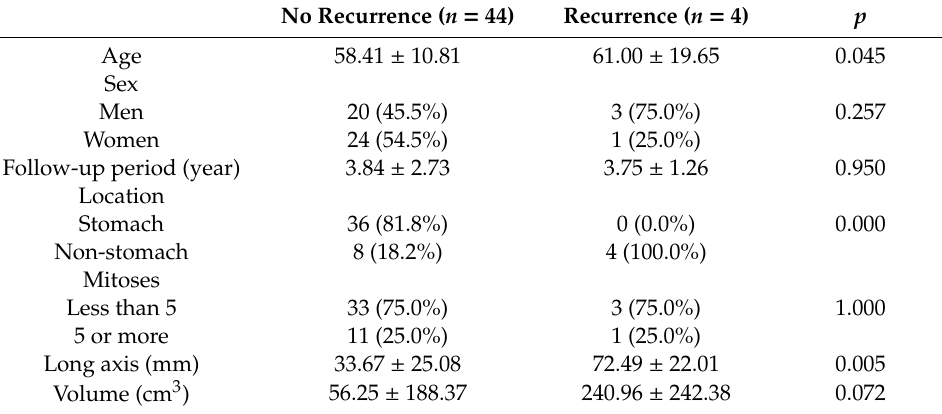
Table 2. Clinical characteristics of patients with recurrent GISTs.